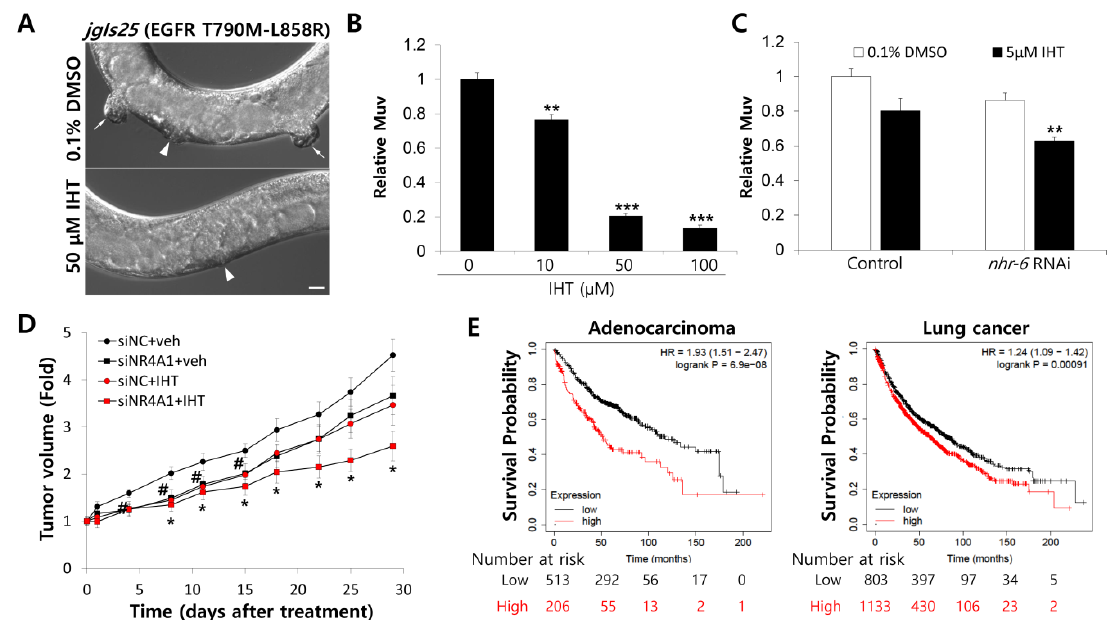
Figure 6. Combination of NR4A1 knockdown and IHT treatment synergistically inhibited multivulva (Muv) formation and mouse xenograft tumor growth. ( A ) The adult animal model of jgIs25 treated with DMSO or IHT was observed using a di ff erential interference contrast (DIC) microscope. Arrowhead = normal vulva. Arrow = hyperplasia. ( B ) The synchronized L1 larvae of jgIs25 (epidermal growth factor receptor (EGFR) T790M-L858R) were treated with IHT at the indicated concentration in liquid culture. Worms with Muv were counted at adult stage, and 0.5% DMSO was used as a control. **, significantly di ff erent from control ( p < 0.01); ***, significantly di ff erent from control ( p < 0.001). Data are presented as mean ± SEM. ( C ) IHT treatment was combined with nhr-6 RNAi. Four L4 larvae of jgIs25 were transferred to DMSO, nhr-6 RNAi, IHT, or nhr-6 RNAi + IHT plates, and mature F1 progeny were counted. For this, 0.1% DMSO and 5 µ M IHT were used. **, significantly di ff erent